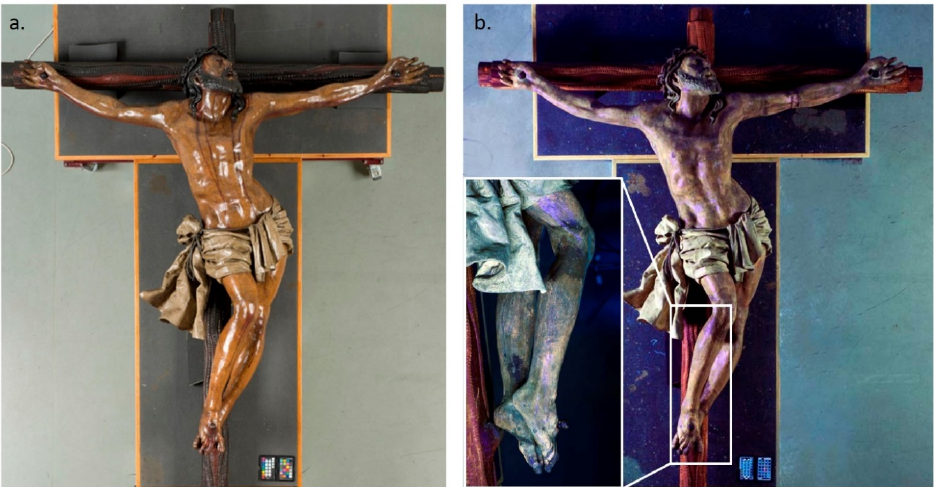
Figure 1. Christ of Expiration (1,875 m) under visible light ( a ) and ultraviolet light ( b ). Ultraviolet light was used to detect previous interventions due to the different fluorescence of the materials. Inset, a detail of the leg of the sculpture where was possible to see the last intervention (darkening